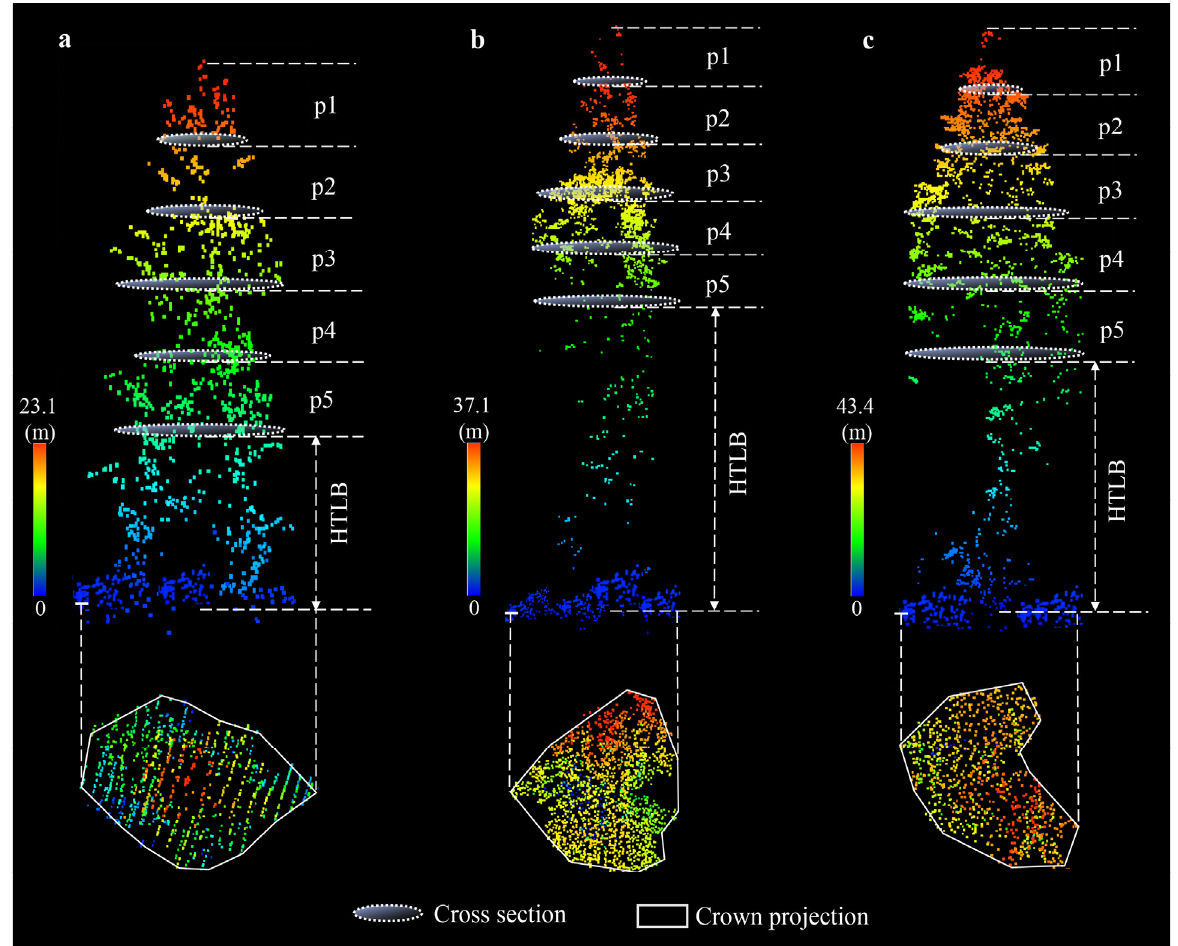
Figure 3. Individual tree’s point cloud and crown projection convex hull of target trees in forest plots. Their crown stratification and cross ‐ section are shown. ( a ) Douglas fir, ( b ) Red alder, and ( c ) Bigleaf maple.